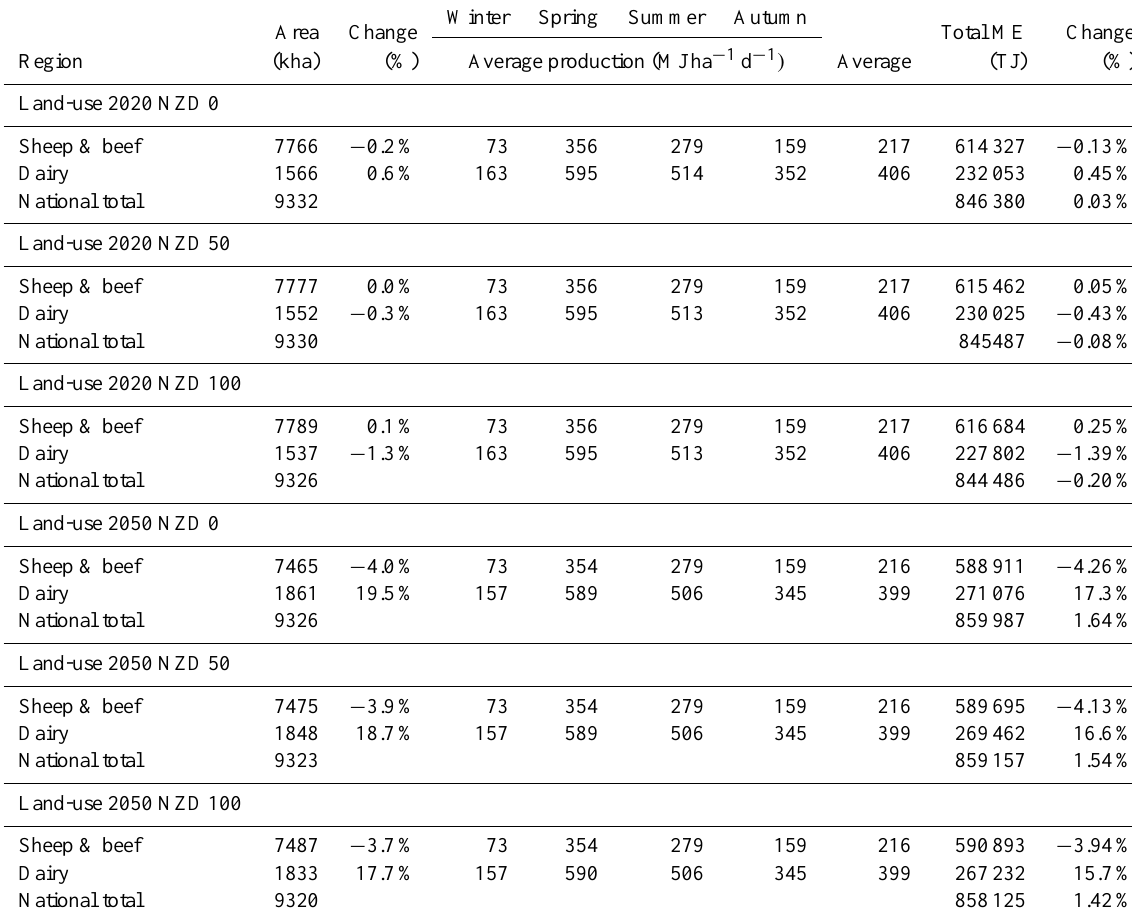
Table 4. Summary of model scenario results with land-use change. Percent change calculated in reference to the baseline scenario in Table 3. Seasonal numbers are averages over the modelled time slice, and national totals are the annual average sum of sheep/beef and dairy results. ME is metabolisable energy, defined as the amount of energy available to grazing